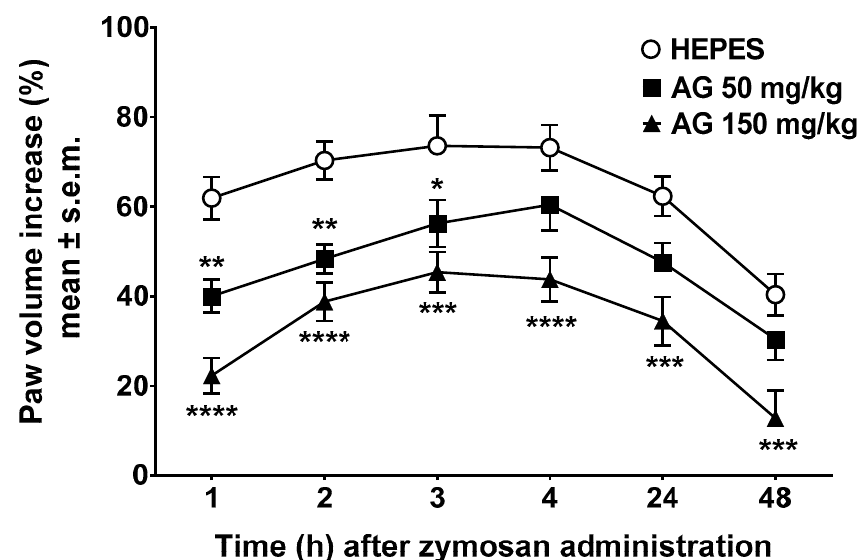
Figure 1. Zymosan-induced paw edema. Effects induced by vehicle (Hepes, 10 mL/kg, intraperitoneally (i.p.)) and ammonium glycyrrhizate (AG, 50 or 150 mg/kg, i.p.) administered 10 min before zymosan (2.5% w/v in saline, 20 µL/paw). * denotes p < 0.05, ** denotes p < 0.01, *** denotes p < 0.001 and **** denotes p < 0.0001 vs. Vehicle. n = 12.